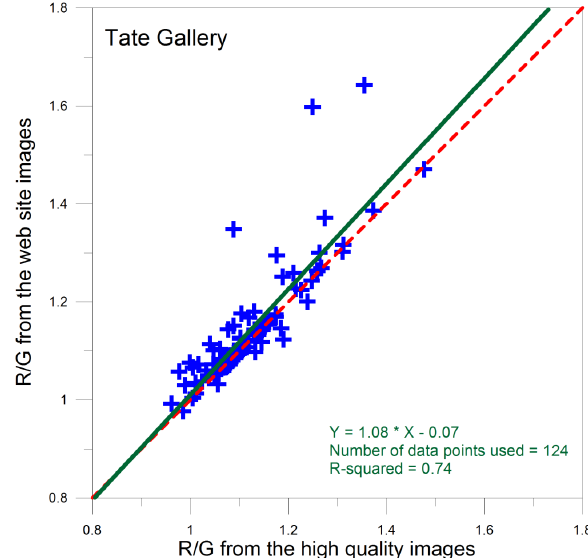
Fig. 1. R/G ratios derived from painting digital images from web site (low resolution) vs. R/G ratios for the same paintings obtained through colour profile protocol (high resolution) at the Tate Gallery. The corresponding linear best fit (green line) and the perfect corre- lation line (dashed red line) are also shown. The values correspond to the 124 landscape paintings listed in Appendix